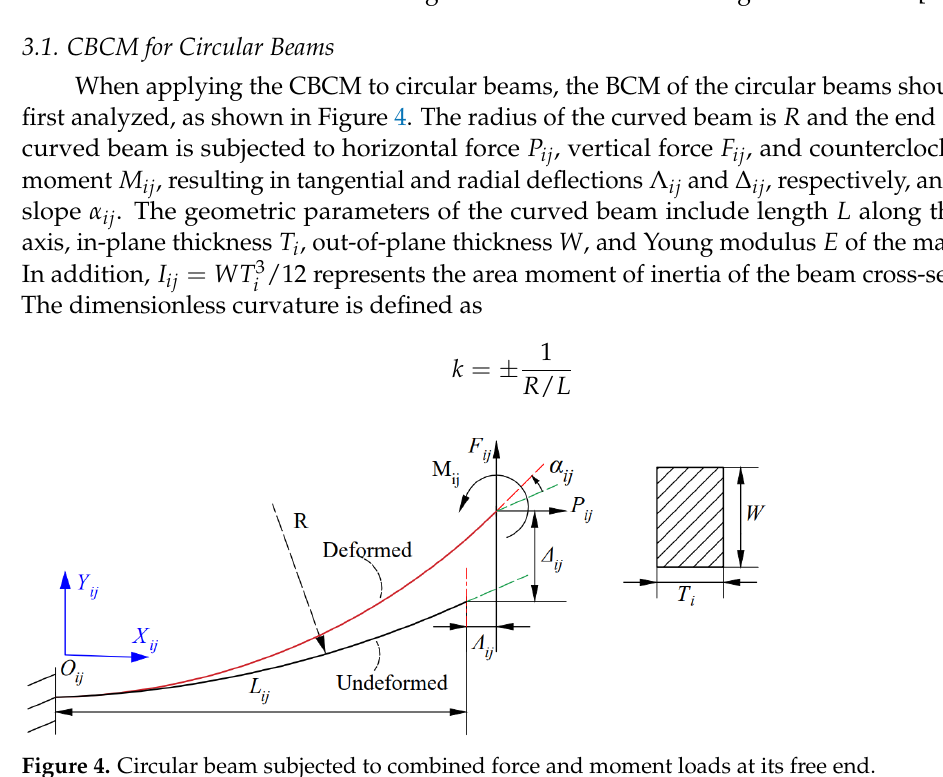
Figure 4. Circular beam subjected to combined force and moment loads at its free